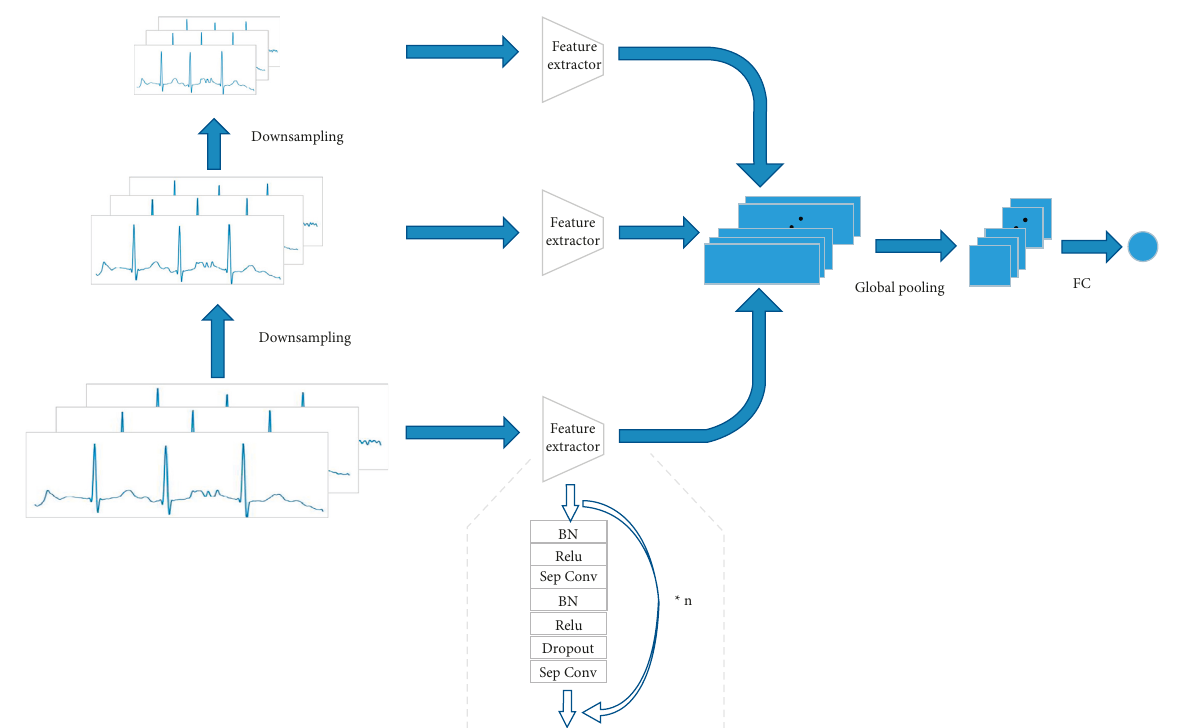
Figure 5: Modified RESNET